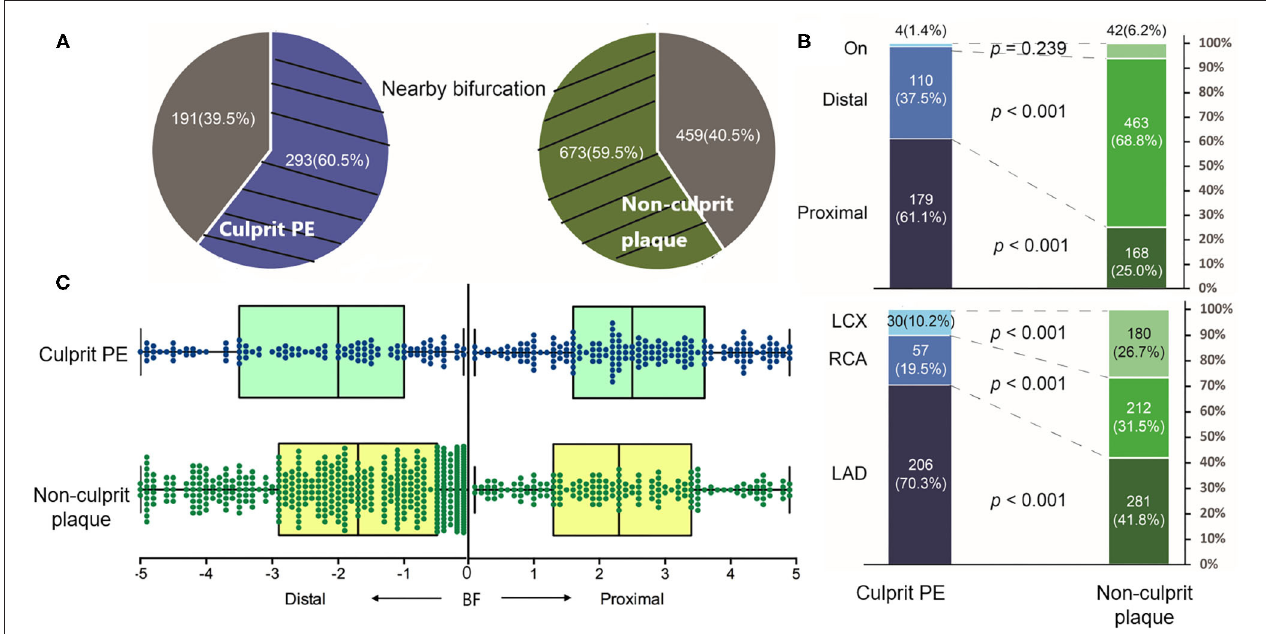
FIGURE 2 | The distribution of culprit PE and non-culprit plaques near a bifurcation. (A) 60.5% culprit PE and 59.5% non-culprit plaques were located near a bifurcation. (B) Among them, culprit PE were mainly located in the LAD (70.3%) and most of them (61.1%) clustered proximal to a nearby bifurcation. On the contrary, most non-culprit plaques (68.8%) clustered distal to a nearby bifurcation. (C) Distance from culprit PE or the non-culprit plaque to the nearby bifurcation was shown. LAD, left anterior descending artery; LCX, left circumflex artery; PE, plaque erosion; RCA, right coronary